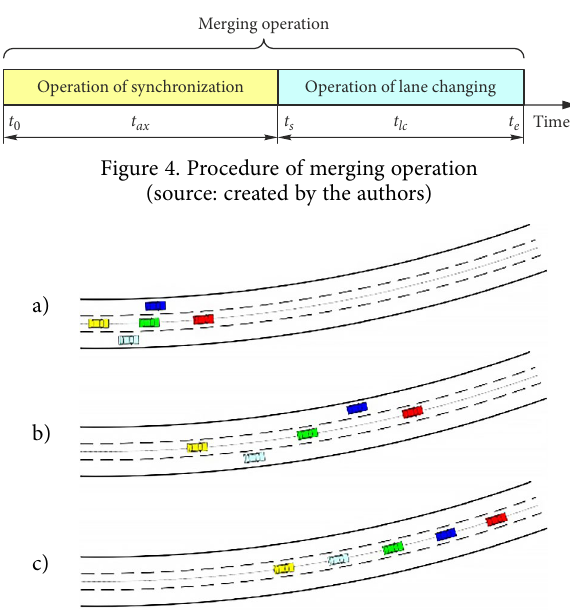
Figure 5. Merging operation (source: created by the authors):